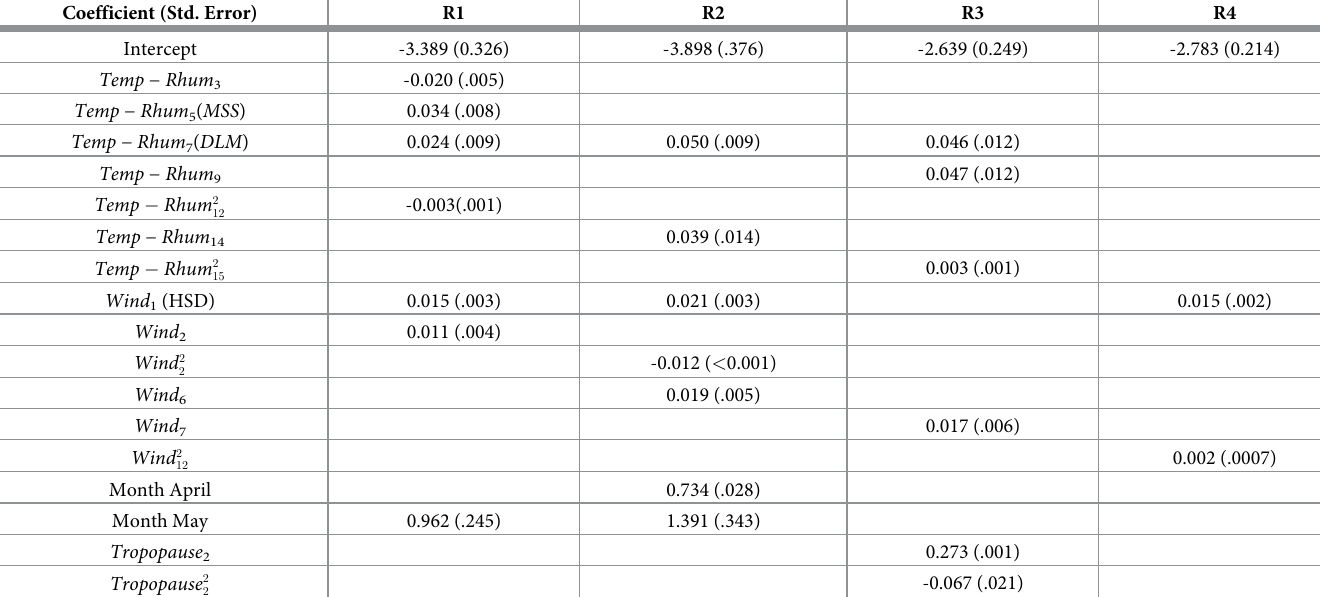
Table 5. Summary of the fitted logistic regression models classifying strong/weak tornado days in each of the four regions. For each region, the table has only the esti- mates of the significant predictors and their corresponding standard error ( Std. Error ). Coefficient (Std.